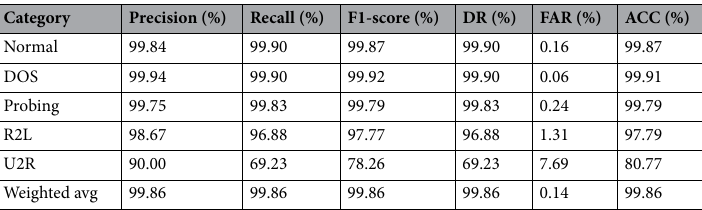
Table 6. Performance of proposed method on KDDTrain+ dataset.